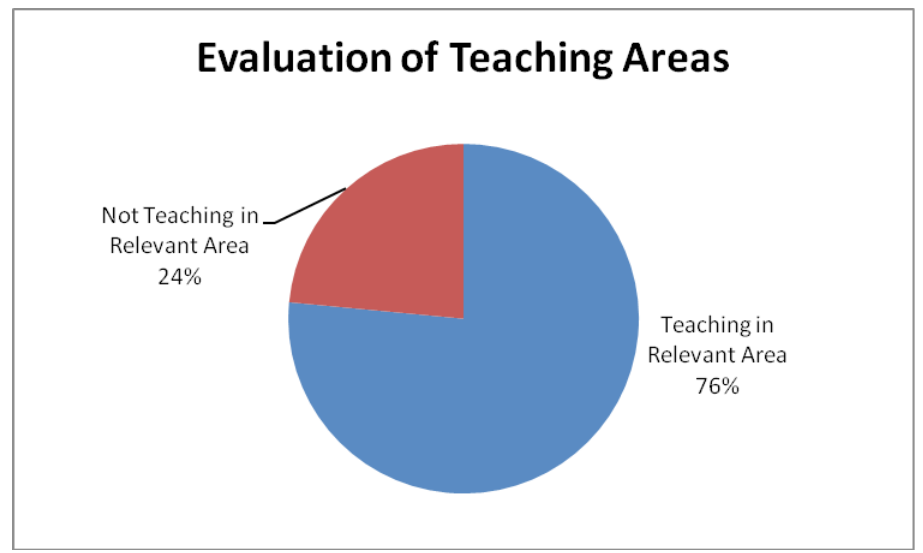
Figure 2. Showing an evaluation of teaching